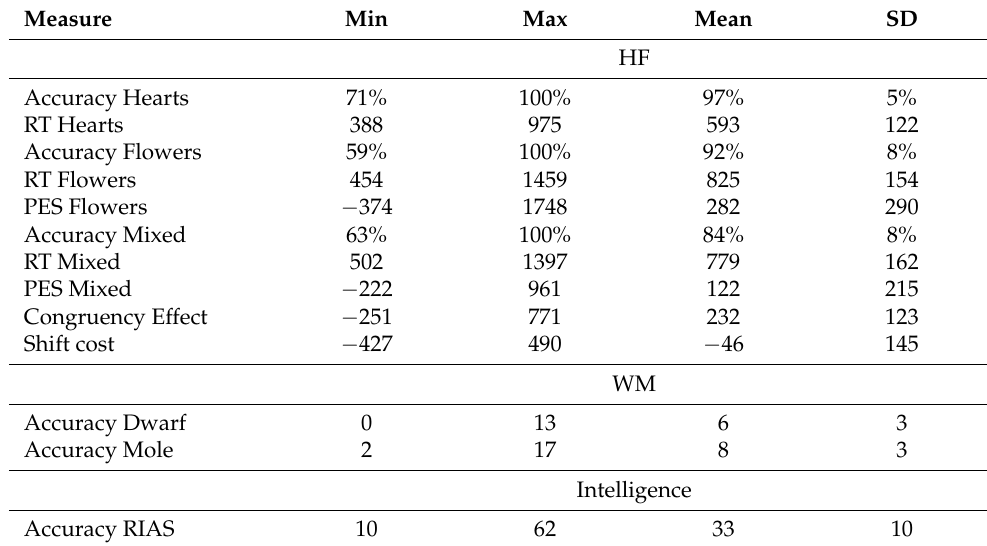
Table 2. Descriptive statistics of measures from EF, WM, and intelligence tasks.